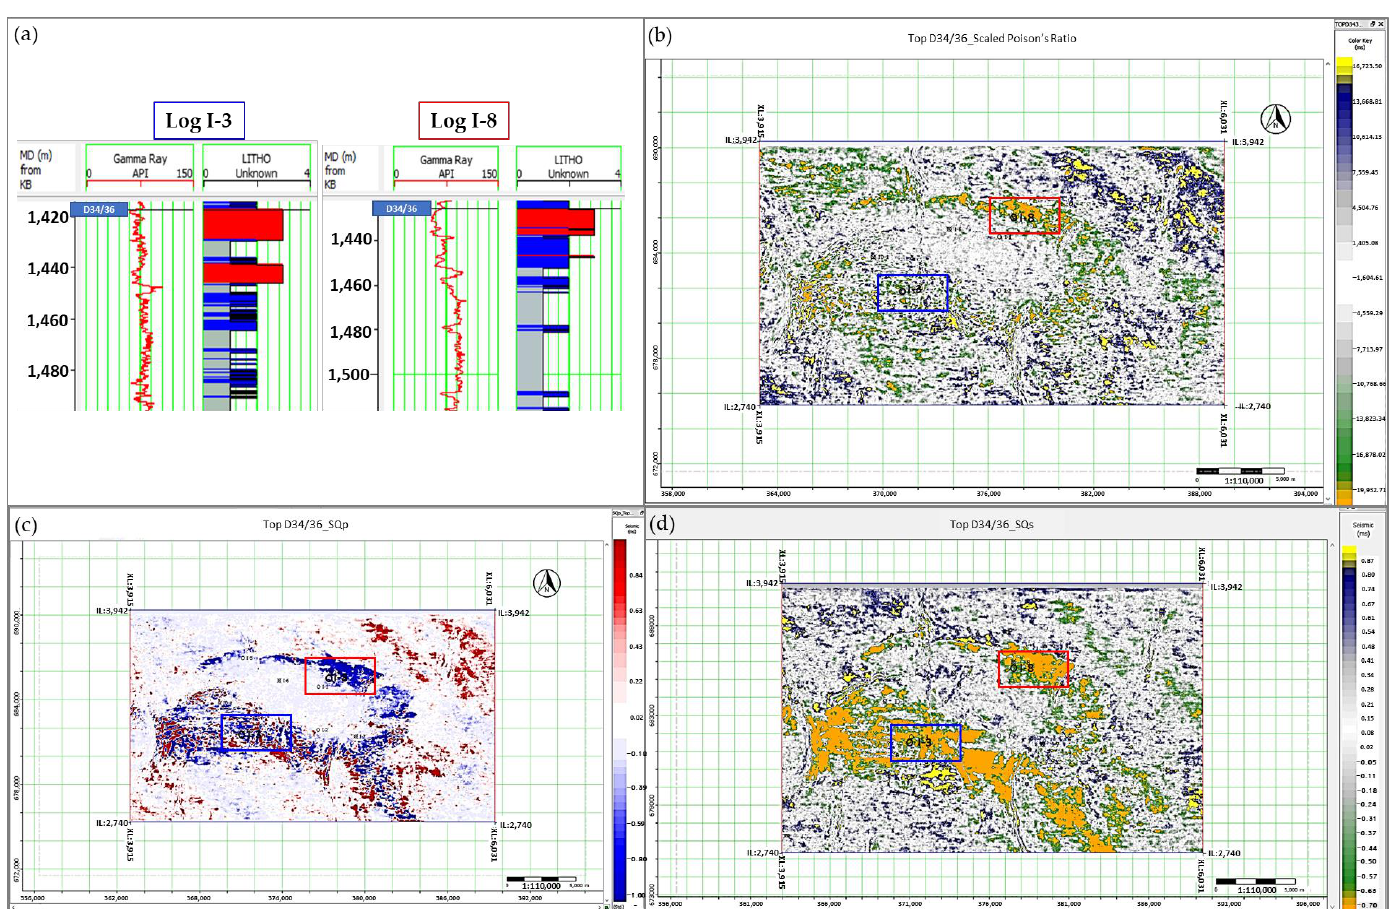
Figure 12. The methods comparison between Scaled Poisson’s Ratio, SQp, and SQs attributes, ( a ) Well log I-3 and I-8 showed that top D34 / 36 was a gas sand interval, ( b ) Scaled Poisson’s Ratio attribute slice could not capture a gas sand interval in well I-3, ( c ) SQp attribute slice gave better resolution, which could capture sand area at well I-3. The sand interval was figured as blue color, and ( d ) SQs attribute gave better resolution which could capture a gas sand area at well I-3. The gas sand interval was figured as orange color.